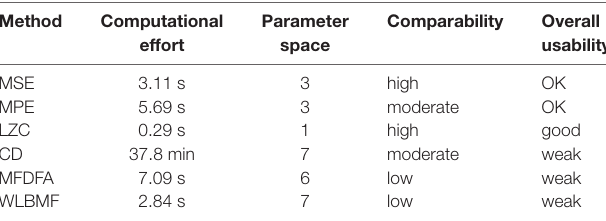
TABLE 2 | Comparison of usability of